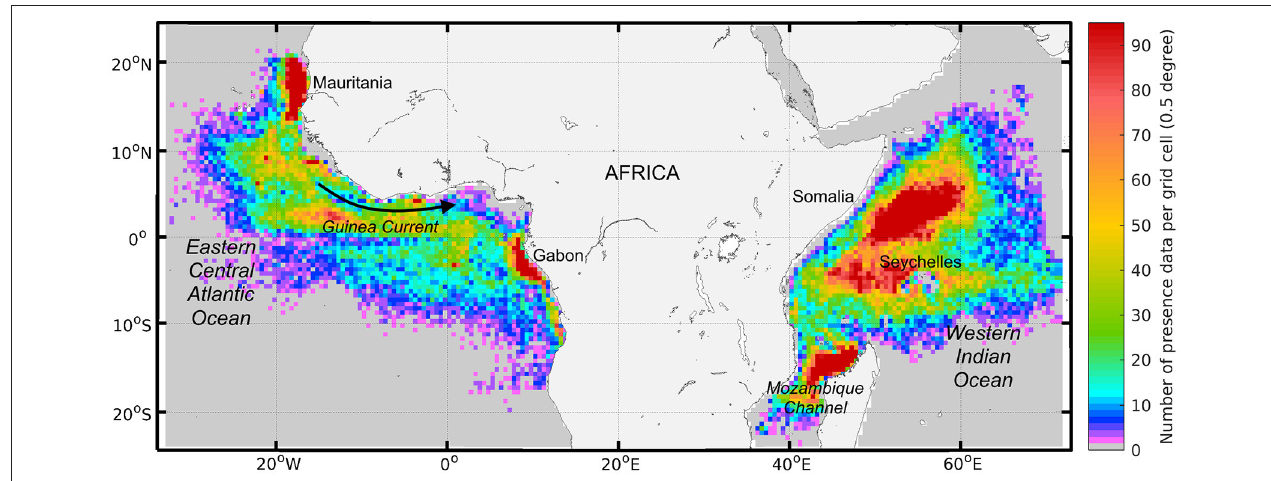
FIGURE 2 | The geographical density of skipjack tuna ( Katsuwonus pelamis , SKJ) presence data for both free-swimming schools and drifting fish aggregating device associated schools ( n = 155,064) collected between 1997 and 2015 by European purse seine fleets (in number of observations by 0.5 degree grid cell). Density quartiles (i.e., 25 th , 50 th , and 75 th percentiles) per grid cell are 4, 12, and 30 and the 95 th percentile is 95.